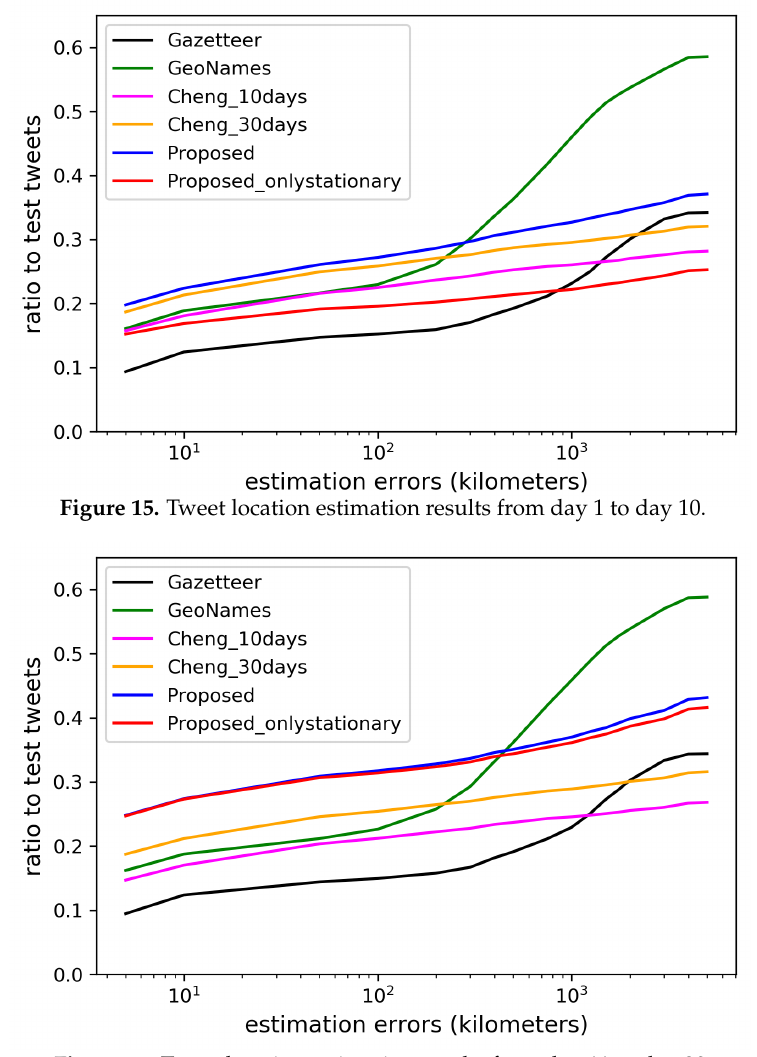
Figure 16. Tweet location estimation results from day 11 to day